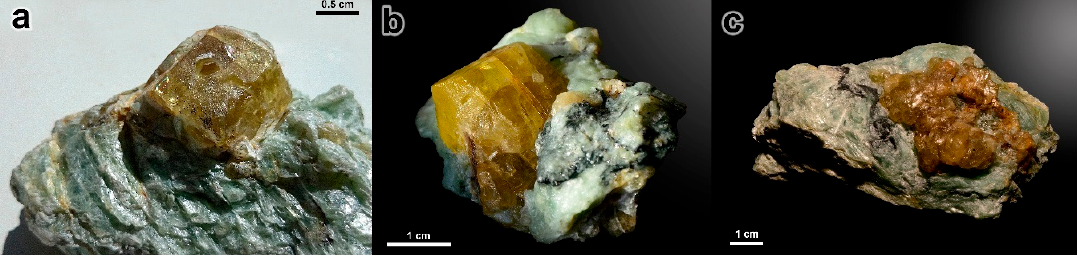
Figure 3. Yellow crystals of apatite: ( a ) hexagonal prismatic crystal in green talc; ( b ) hexagonal prismatic crystal in white to grey magnesite; ( c ) aggregate of apatite crystals in green talc. Photo by T. Bancík.